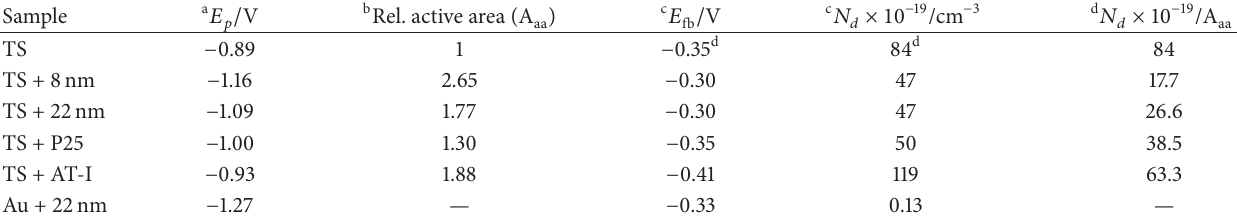
, and 𝑁 𝑑 determined from fb